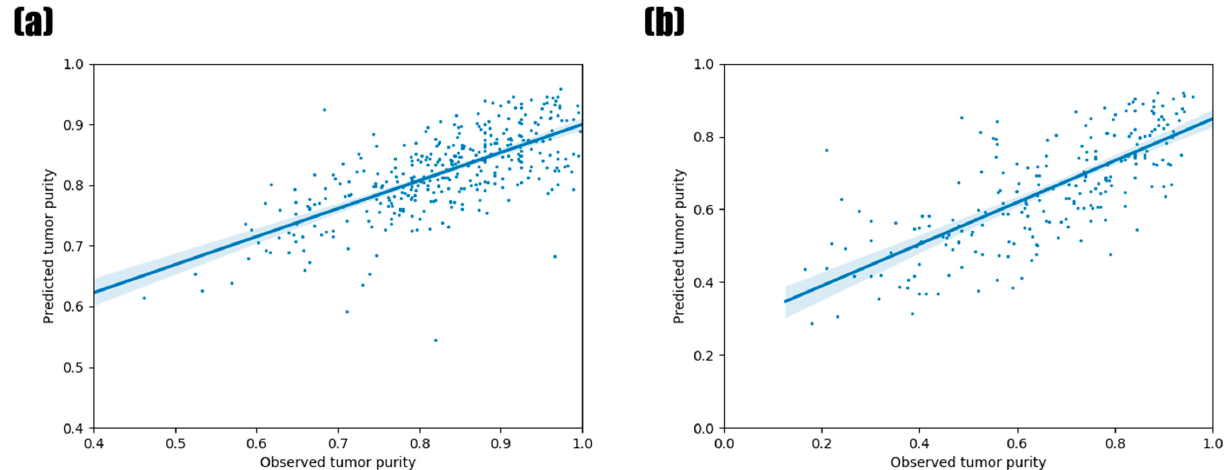
Figure 4. Prediction of tumor purity using validation datasets based on the top 10 miRNAs. ( a ) TCGA tumor types not used in our model construction. ( b ) PCAWG test dataset. The fitted line by linear regression is also shown with a 95% confidence interval. The plot was generated by regplot() in the seabon package of Python.